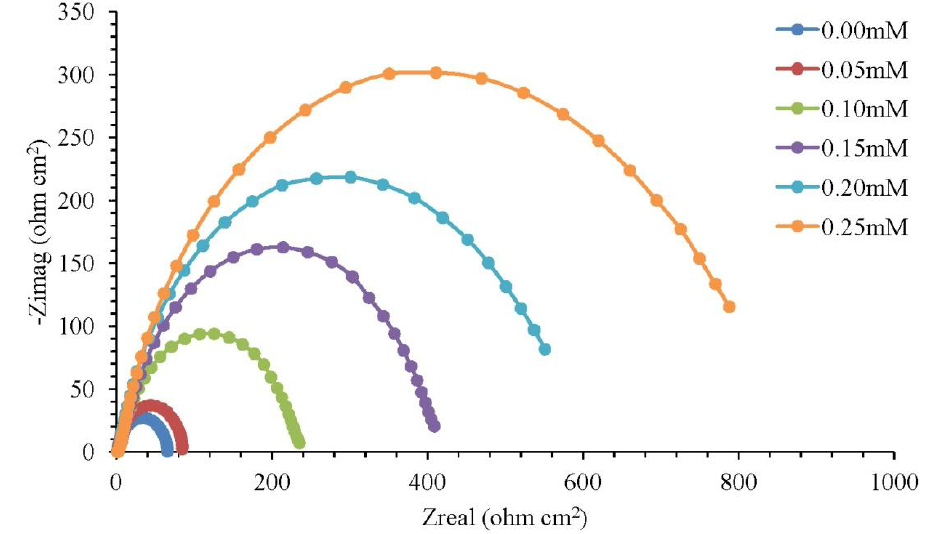
Figure 1. Nyquist plot for mild steel in 1.0 M H corrosion inhibitor at 30